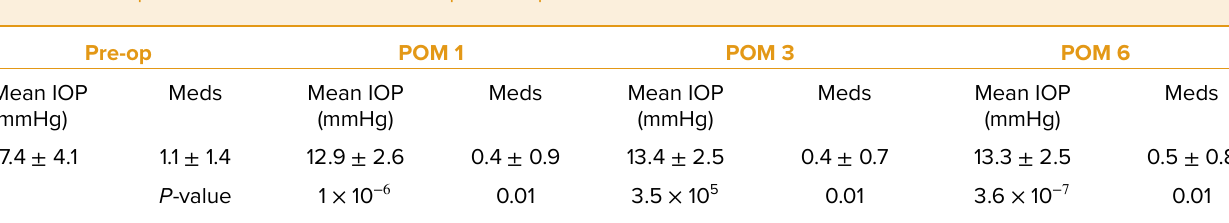
Table 2. Preoperative patient characteristics MD (dB) PSD RNFL thickness –5.9 ± 7.8 4.3 ± 3.2 74.5 ± 15.1 1.75 ± 1 23.9 ± 6.1 549.6 ± 39.3 102.4 ± 8.1